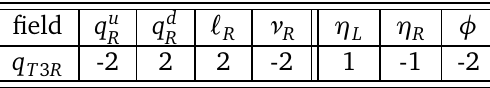
. The charges are T 3 R